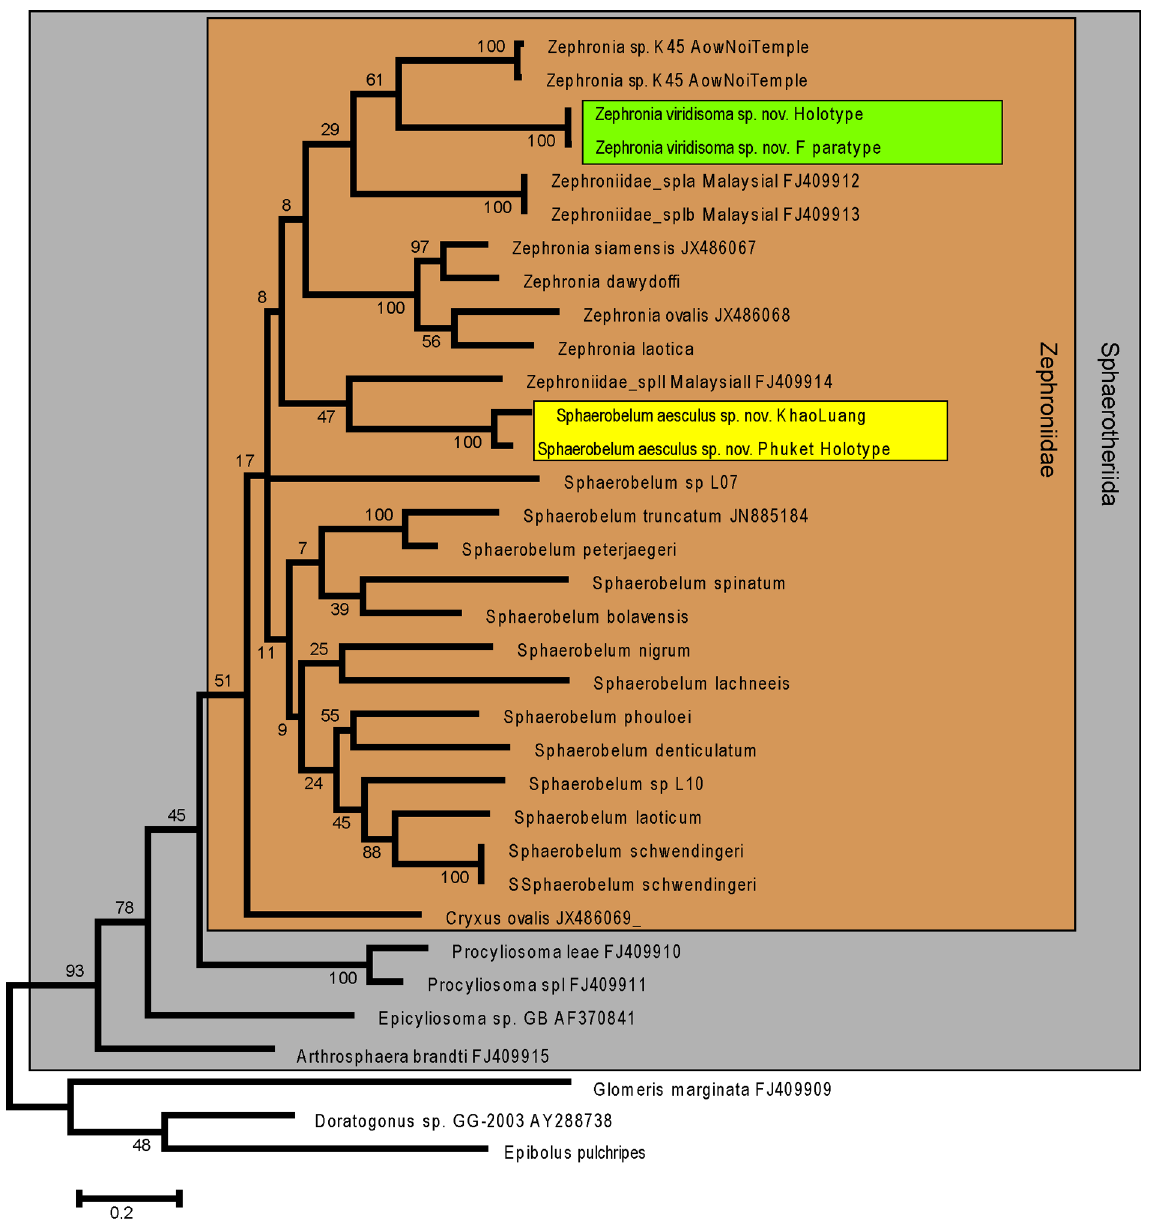
Fig. 1. The evolutionary history of the analyzed Sphaerotheriida Brandt, 1833 inferred by using the Maximum Likelihood method analyzed with the General Time Reversible model based on the COI gene. The tree is drawn to scale, with branch lengths measured in the number of substitutions per site. Codon positions included were 1 st +2 nd +3 rd . All positions with less than 5% site coverage were eliminated. Yellow and green boxes mark the newly described species. Numbers below branches mark bootstrap values (1000 replicates). For specimen information see Table